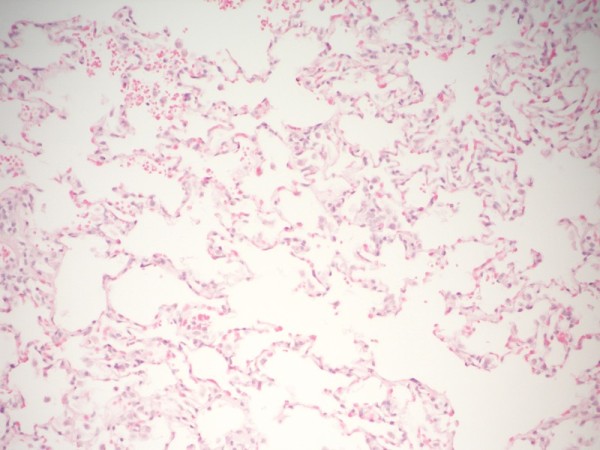
Appearance of lung tissue of the normal rats ( H&E, X200).